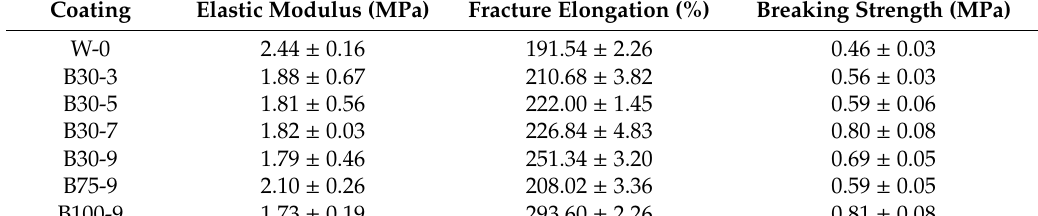
Table 4. Mechanical properties of coating.